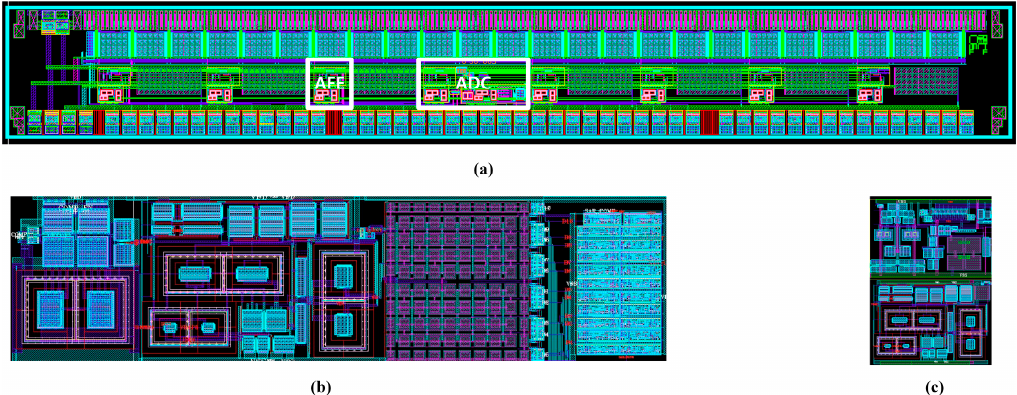
Figure 12. ( a ) ROIC layout; ( b ) ADC sub-block, ( c ) AFE sub-block. Table 5. Specification of the fingerprint sensing system.